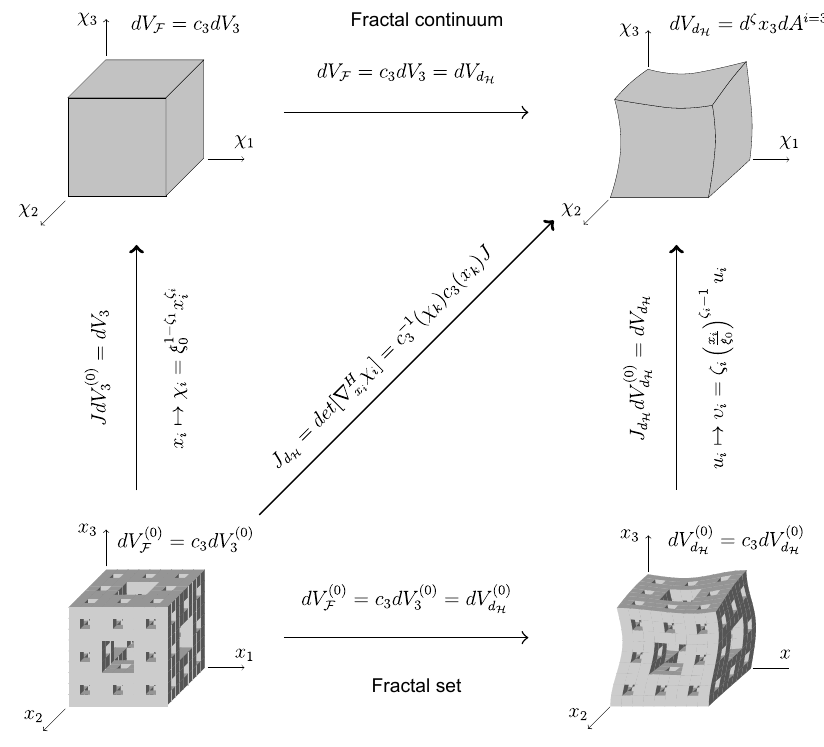
Figure 2. Geometrical interpretation of mapping of Menger sponge F 2.72 F 3 from the original to deformed configurations 2.72